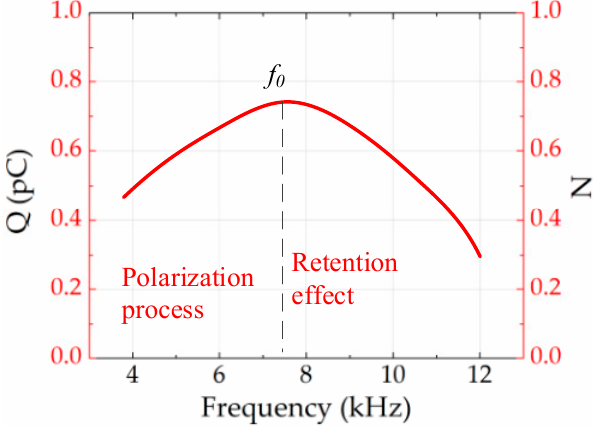
Figure 13. Theoretical analysis of PD number and magnitude at different frequencies.